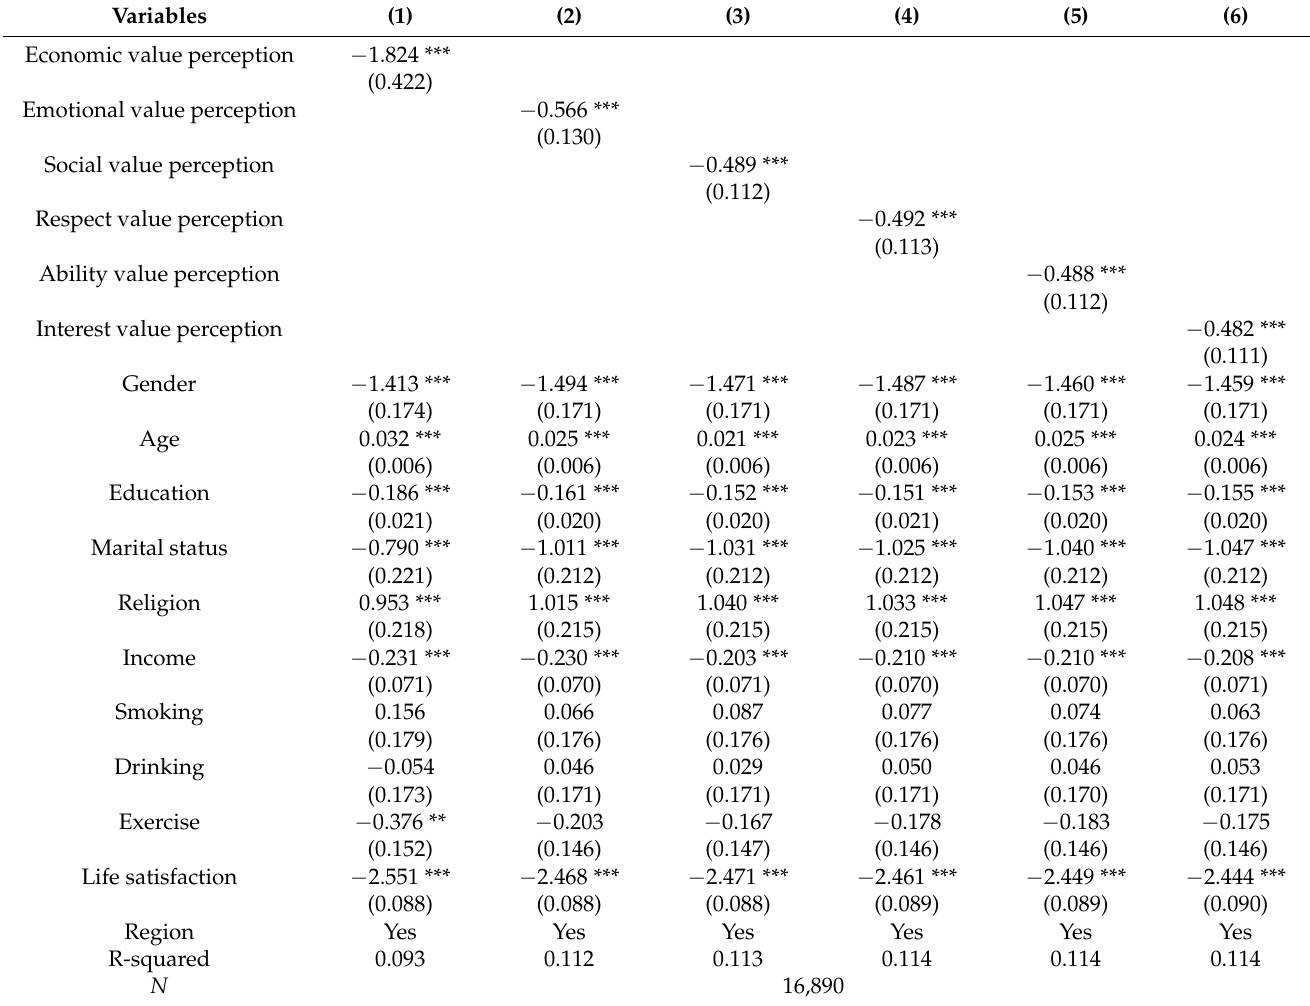
Table 5. Impacts of different work value perception dimensions on workers’ mental health (IV − 2